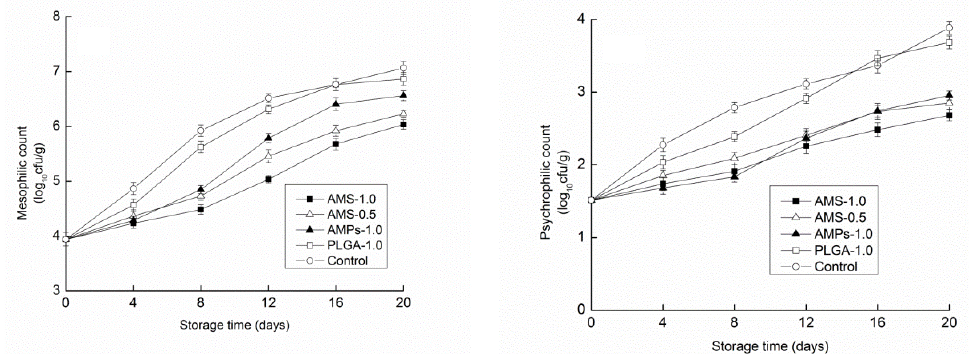
Figure 8. Effect of different antimicrobial coatings on mesophilic and psychrophilic count changes of Tricholoma matsutake stored at 4 ± 1 °C for 20 days.